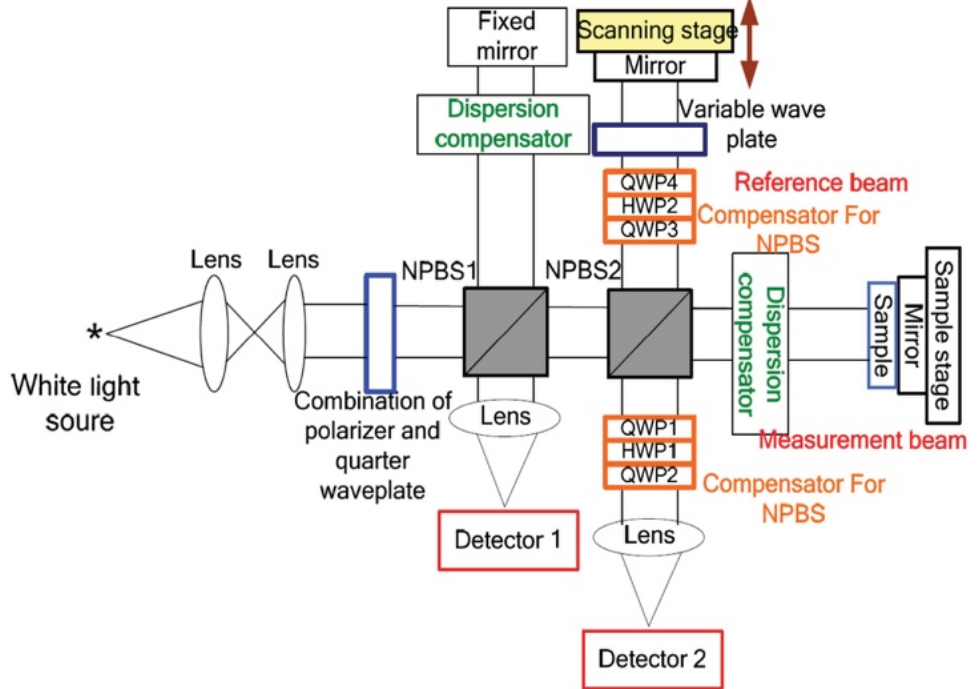
Figure 14. Schematic illustration of the Mueller OCT system consisted of a halogen lamp, two photo-detectors, a scanning stage, a scanning stage driver, a dispersion compensator, an oscilloscope, and two nonideal beam splitters. Compensation for the polarization distortion was performed using a composite polarizer component comprising a quarter-wave plate, half-wave plate, and second quarter-wave plate. Reprinted with permission from [62].